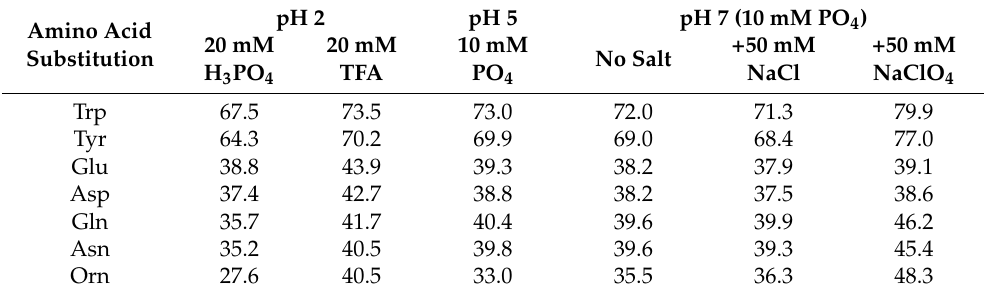
Table 8. Peptide retention times in various mobile phases (absence of the nearest group effect) [29]. Amino